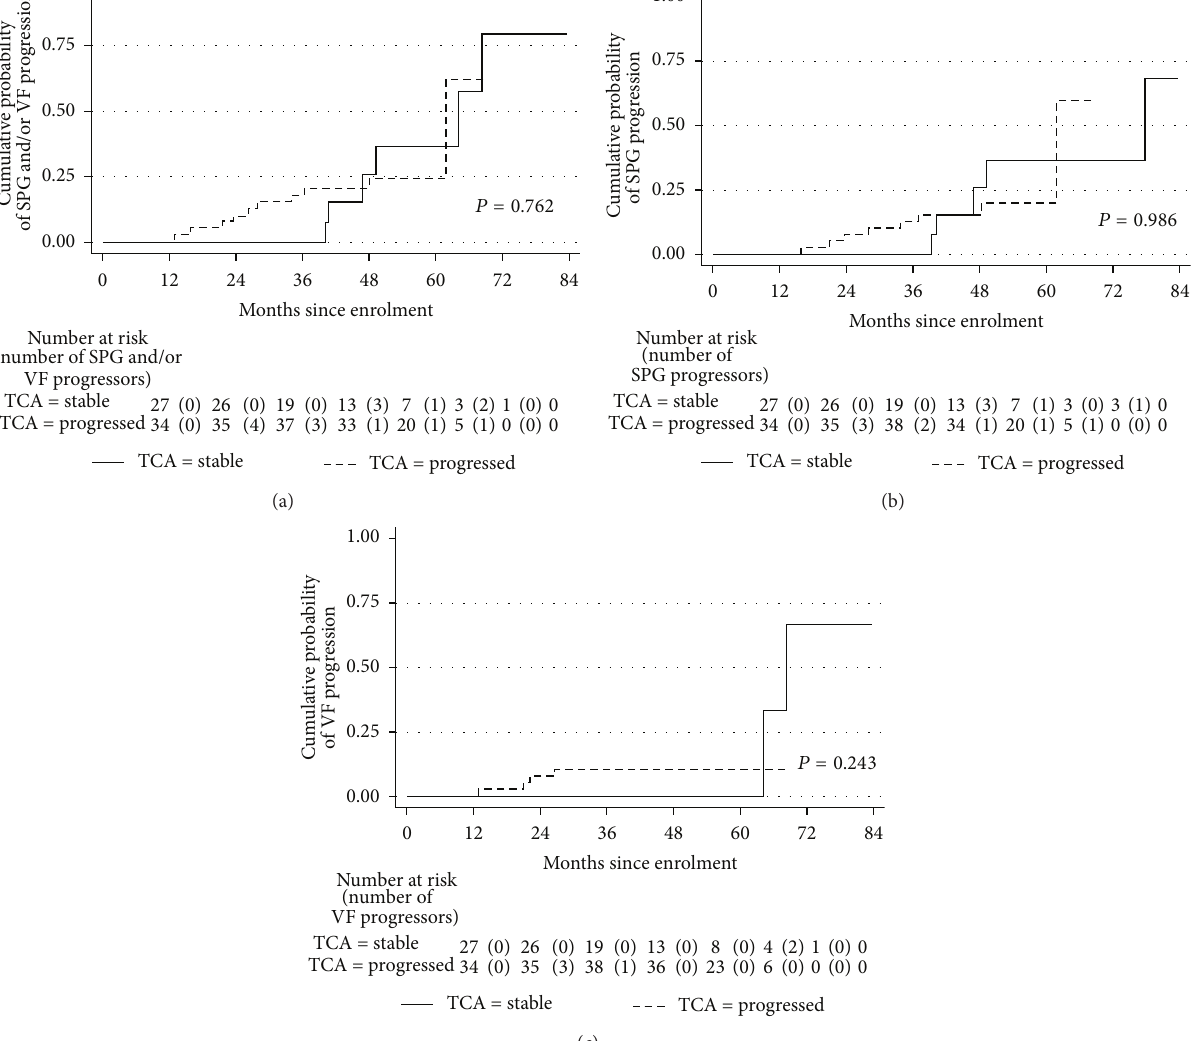
28.2% by 3, 4, and 5 years after enrollment, respectively, compared with 0.0%, 28.6%, and 40.5% in TCA-stable eyes (log rank 𝑃 = 0.83 ). TCA progression was not